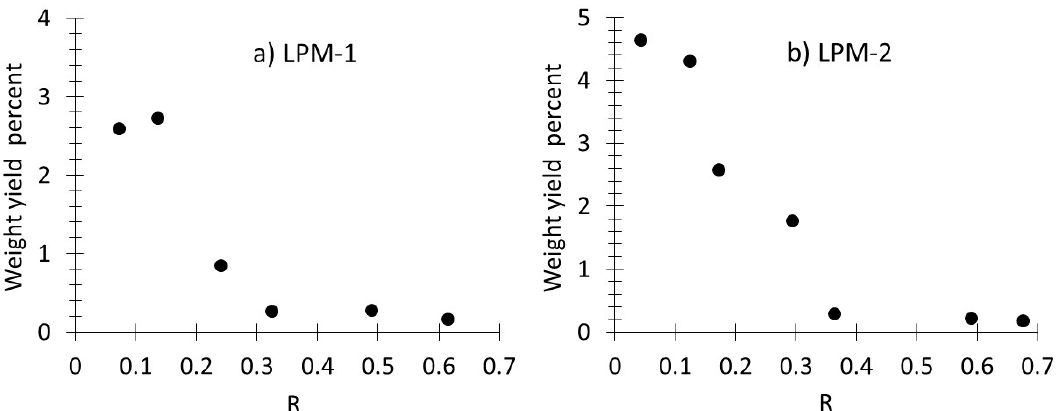
Figure 2. Production yield for different syntheses as a function of the R parameter for ( a ) LPM-1 and ( b ) LPM-2.